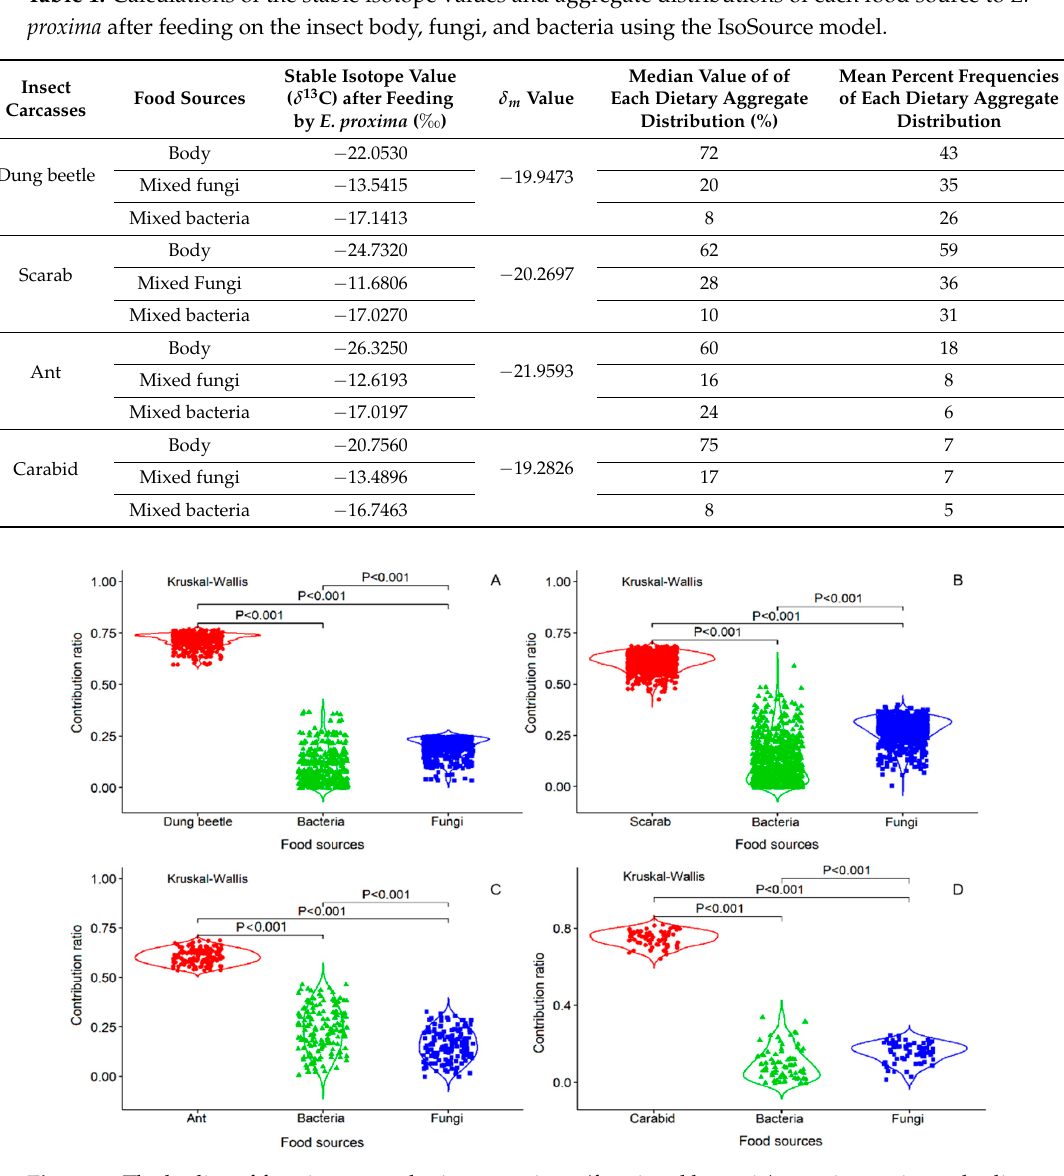
Figure 2. Dietary biomass proportions of the three aggregate food sources for E. proxima . The aggregate solutions are sums of the biomass contributions for the food sources in each category (insects body, mixed bacteria, and mixed fungi). Increments of 2% were used to calculate the aggregate contributions in the model iterations.